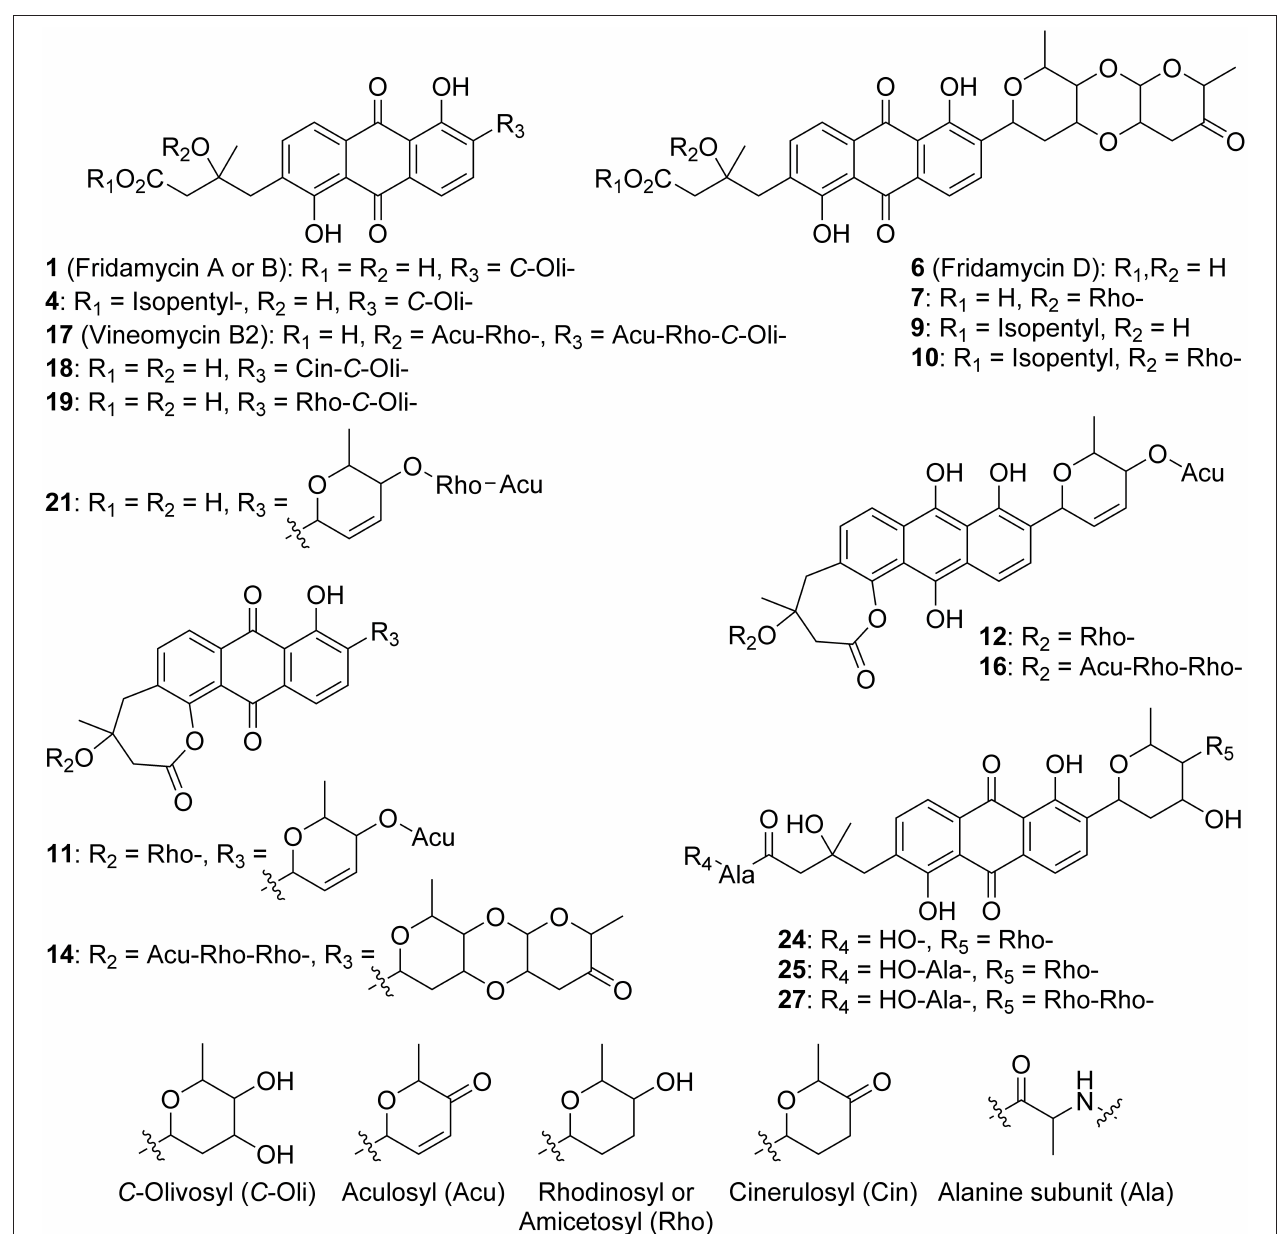
FIGURE 4 | Annotated metabolites from RO-S4 strain. Stereocenters are intentionally drawn as undefined. Only the raw formula of the substituents can be inferred from the mass spectra. Their developed formulas and relative positions are